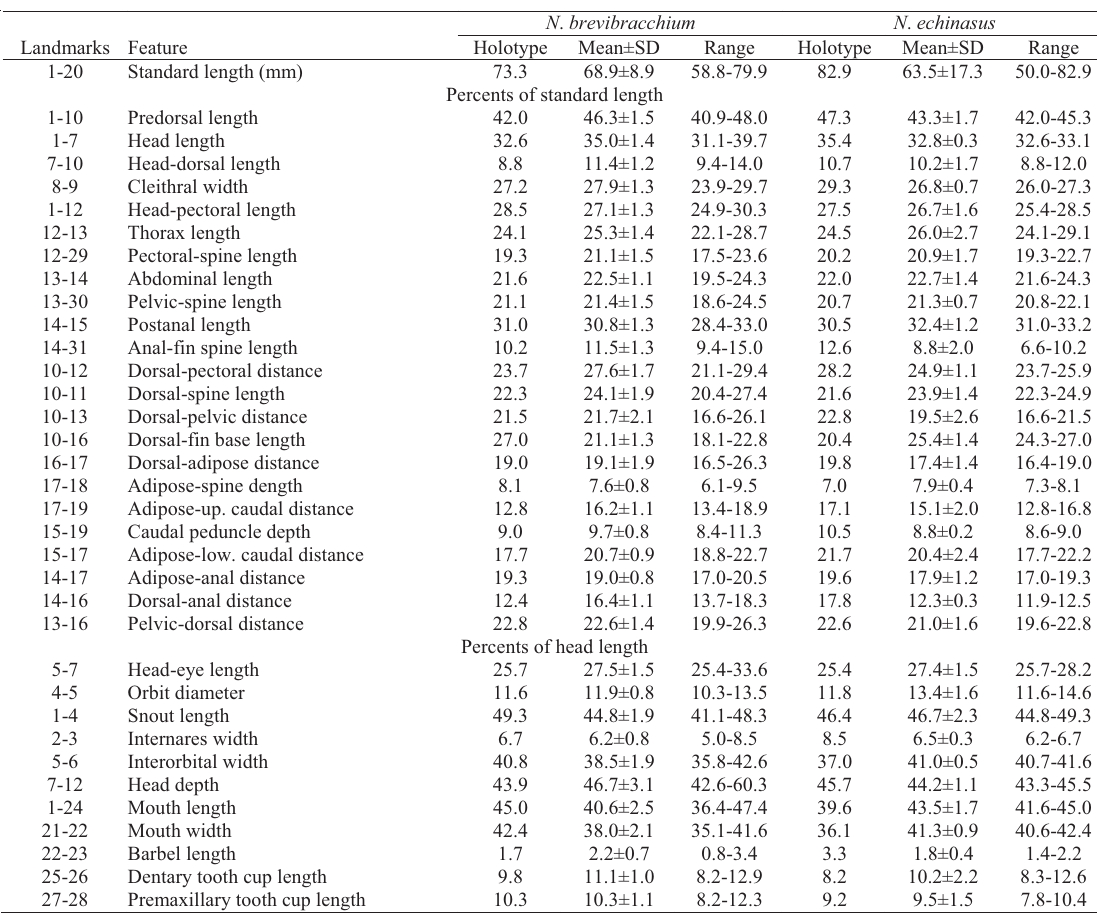
Table 1. Morphometric features of Neblinichthys brevibracchium , new species (N = 11) and N . echinasus , new species (N = 3). Landmarks are the numbered landmarks in Armbruster